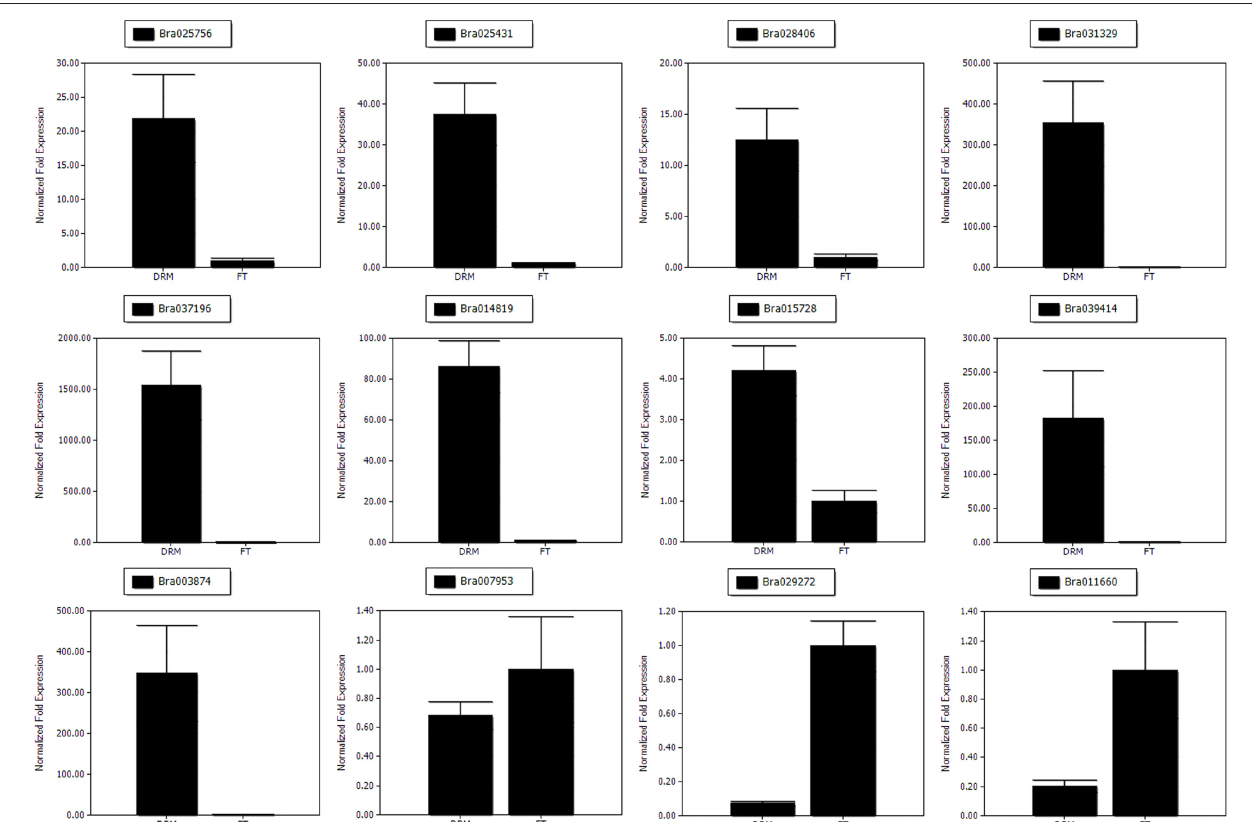
Frontiers in Plant Science |